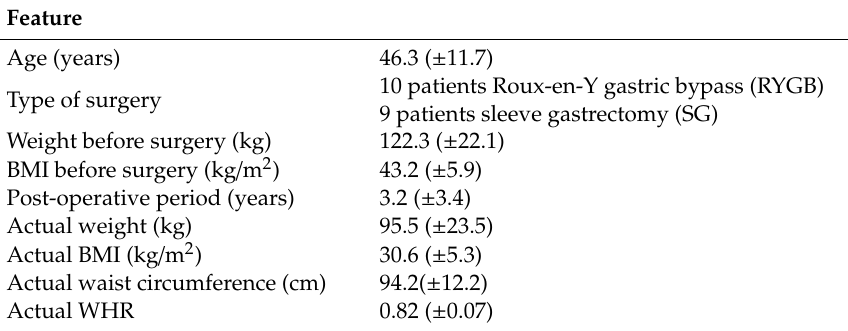
Table 1. Characteristics of the study group.